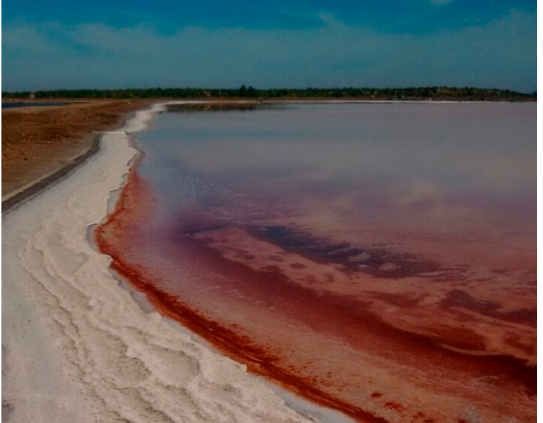
Figure 2. Santa B á rbara saltern, Huatabampo, Sonora.